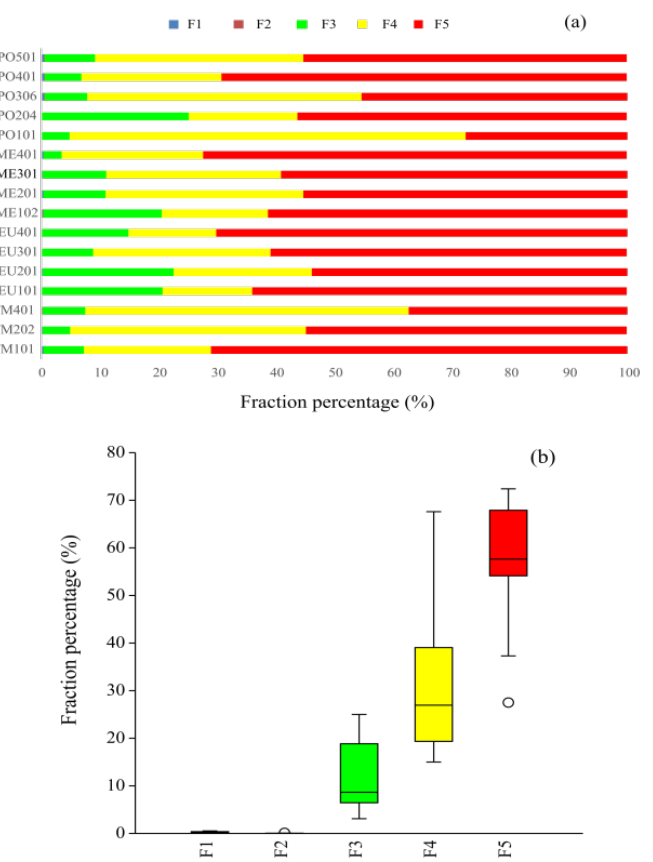
Figure 3. Partitioning of Hg is expressed as a percentage in ( a ) sampled sites according to Bloom’s procedure and ( b ) box plots representing the average percentage ( ± s.d.) for each fraction extracted. Table 4. Speciation of Hg in the sediment of some coastal sites obtained by Bloom speciation. Modified from Covelli et al.